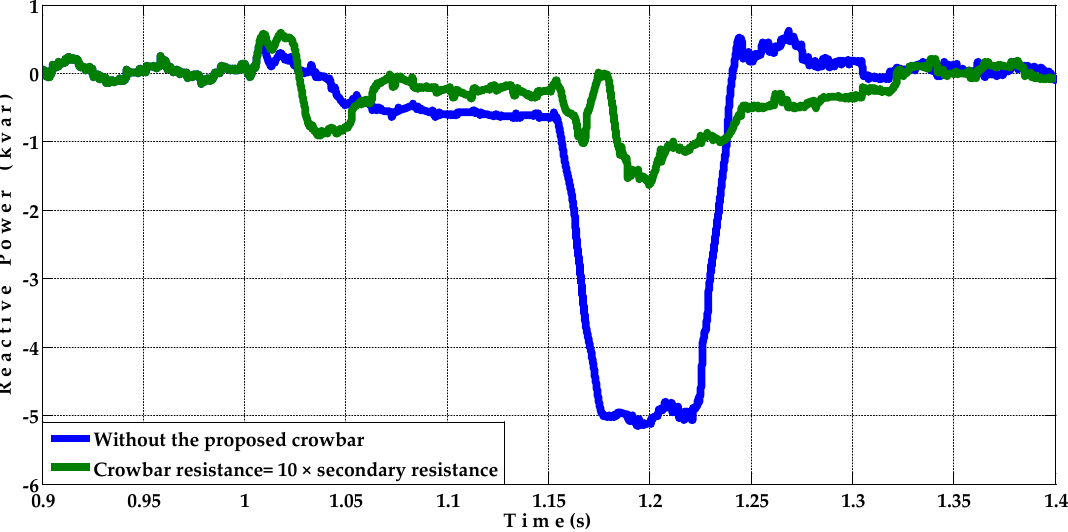
Figure 31. Reactive power of BDFRG with and without the proposed crowbar under double line to ground fault occurrence.